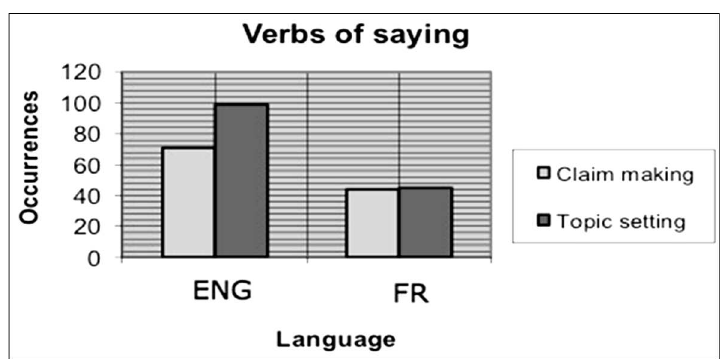
Claim making vs. Toping setting in the two